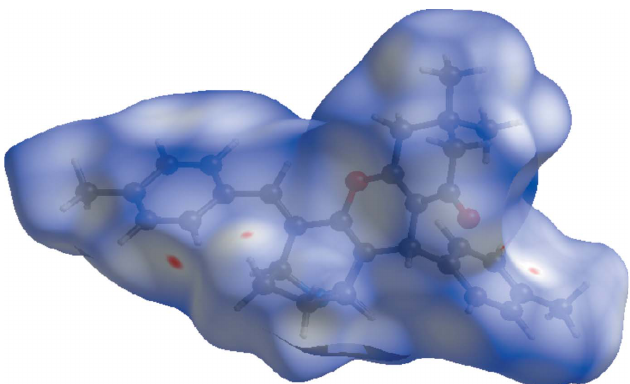
Figure 6 A view of the Hirshfeld surface mapped over d norm in the range (cid:4) 0.0701 to +1.6693 arbitrary units for compound (I).